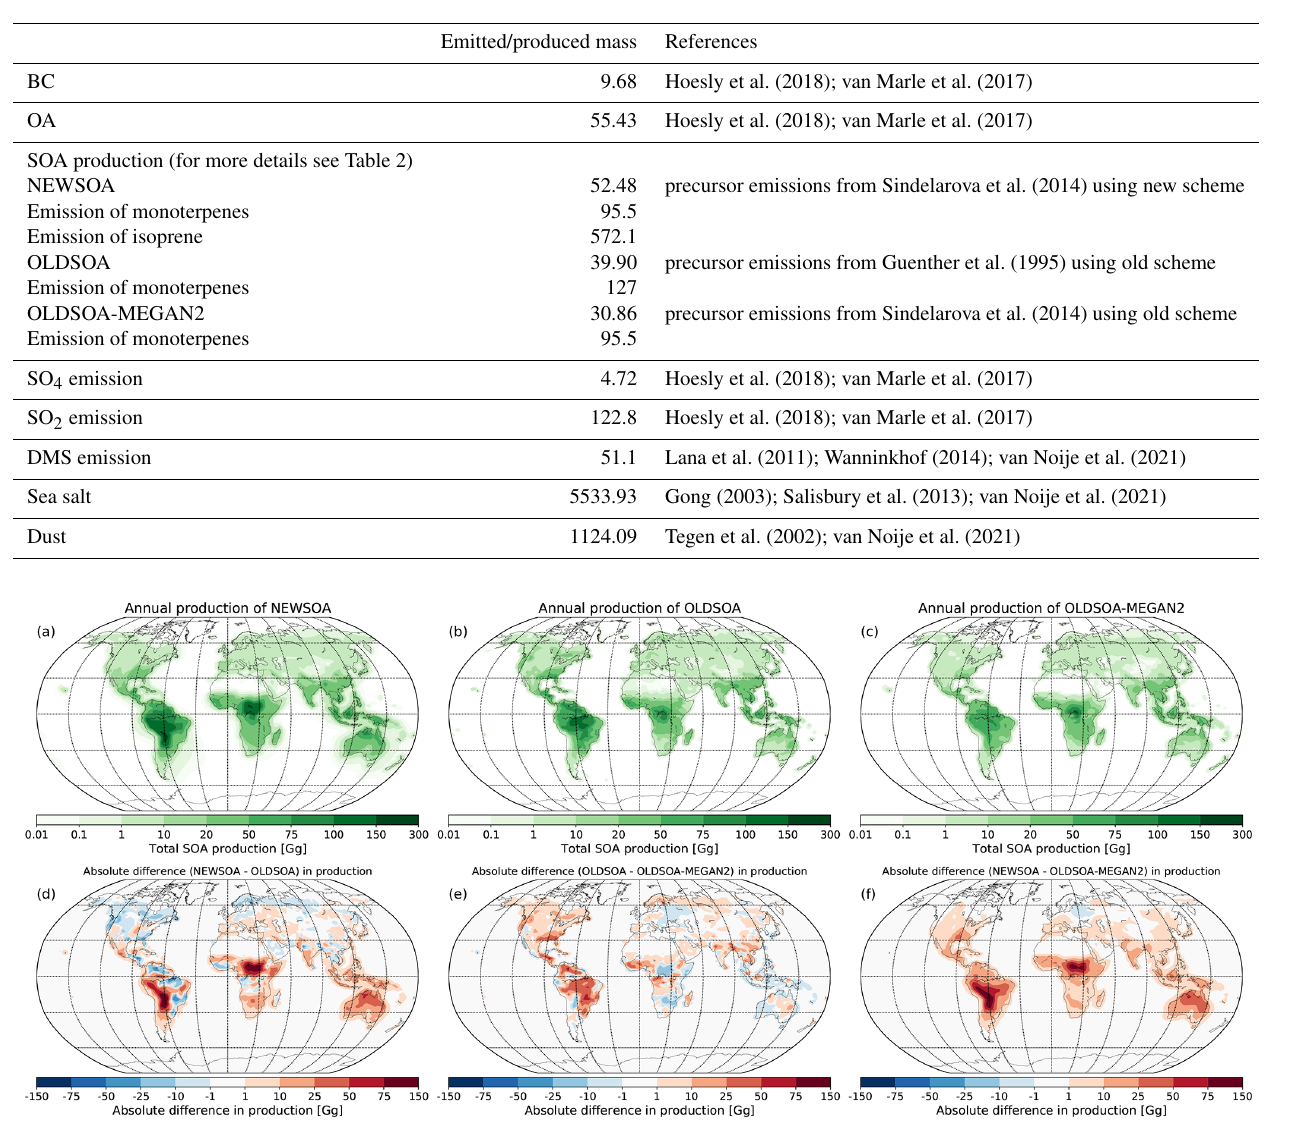
Table 2. Emissions of precursor gases and particulate-phase compounds in the simulations NEWSOA and OLDSOA. Numbers are indicated in teragrams (Tg) per year for emissions.